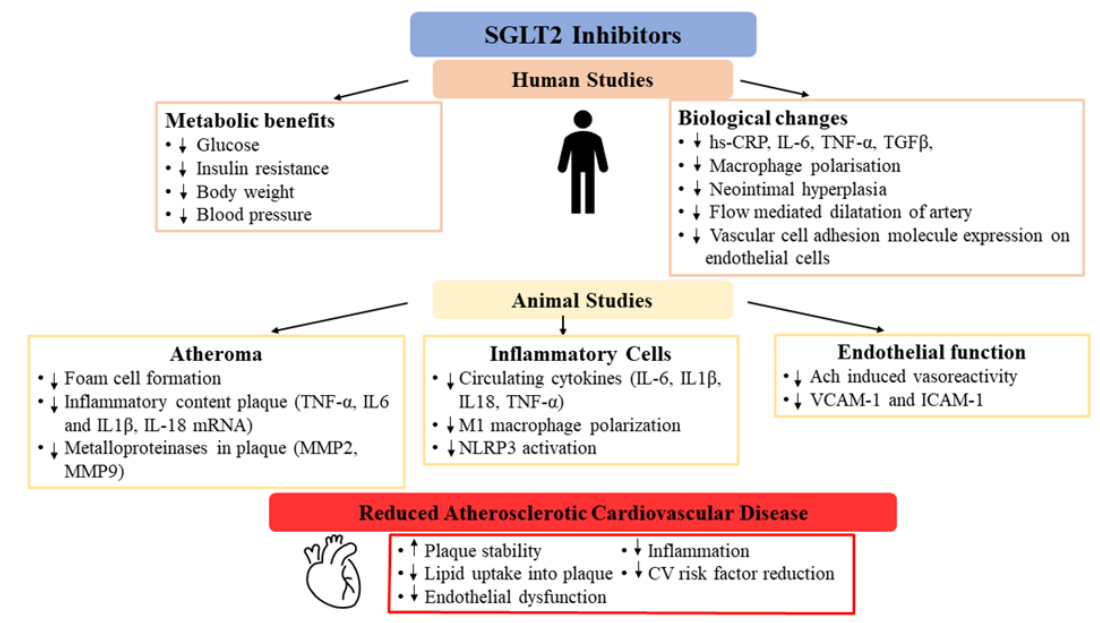
Figure 1. Mechanisms of action of SGLT2 inhibitors in atherosclerotic cardiovascular disease; Ach — acetylcholine; hs- CRP — high sensitivity C reactive protein; ICAM — intercellular adhesion molecule; IL — interleukin; NLRP3 — NLR family pyrin domain containing 3; CV — cardiovascular, VCAM — vascular cell adhesion molecule; TNF — tumour necrosis factor; TGF — transforming growth factor.